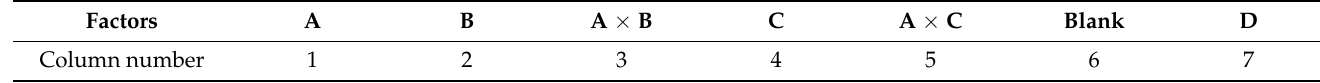
Table 4. Basic parameters of the